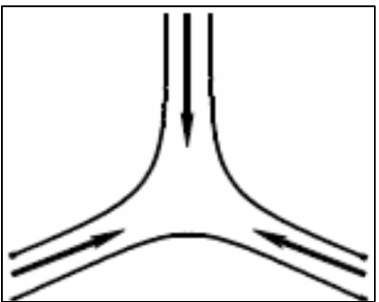
Figure 14. Schematic of liquid draining into the plateau border (Davis et al. [35]).